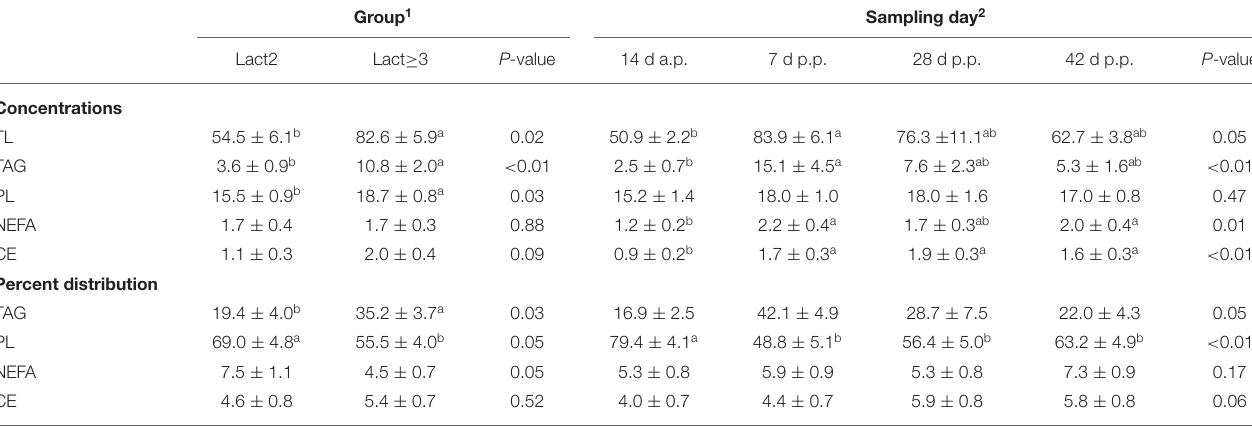
TABLE 1 | Least square means ± standard errors and F-test results ( P-values ) for the main effects group and sampling day of total lipid (TL) content and the concentrations of lipid fractions triacylglycerol (TAG), phospholipids (PL), non-esterified fatty acids (NEFA), and cholesterol esters (CE; in mg/g liver fresh weight) as well as for the percent distributions of the lipid fractions TAG, PL, NEFA, and CE of TL.